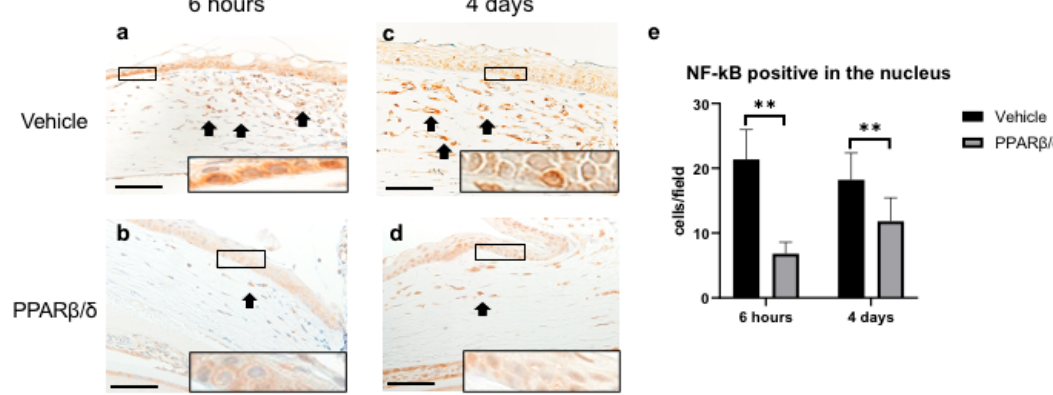
Figure 3. Immunostaining of NF- κ B and quantitative evaluation analyzed by cell counting on the corneal periphery in each group. ( a , b ) Representative sections at 6 h after the injury are shown. As compared to the PPAR β / δ group, the vehicle group exhibited strong staining in the nucleus of inflammatory cells (see boxed area). ( c , d ) Representative sections at day 4 after injury are shown. Higher magnification pictures of the boxed area are also shown. NF- κ B-positive inflammatory cells (black arrows) were observed in the corneal limbs. Bar, 50 µ m. The number of cells stained in the nucleus was significantly lower in the PPAR β / δ group versus the vehicle group at each of the time points ( e ). Data are presented as mean ± SD ( n = 8) ** p < 0.01.